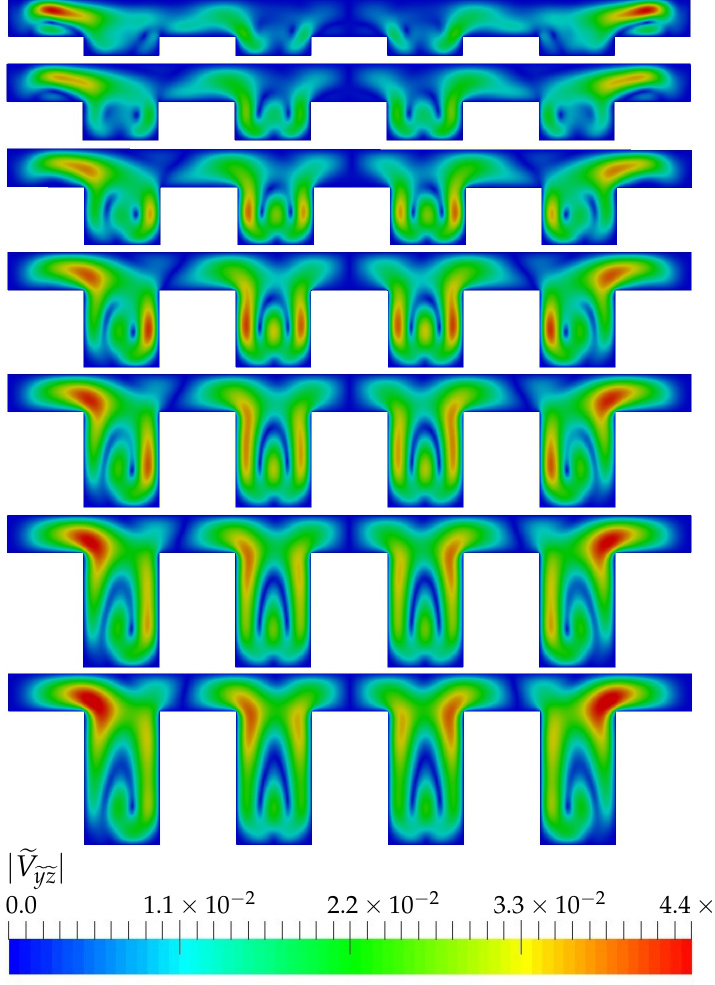
Figure 6. Transverse velocity at plane S 1 for Re = 400, TR = 0.5 and different AR